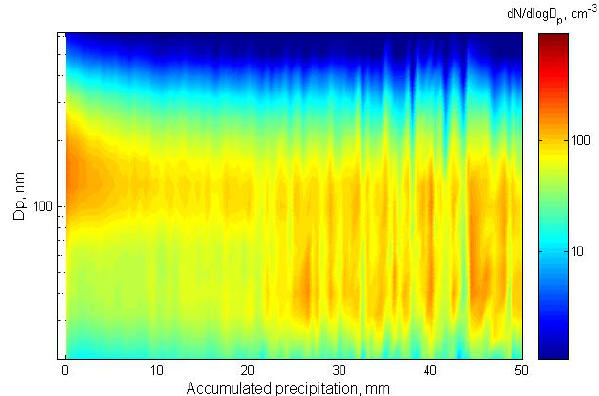
Fig. 16. Evolution of aerosol number size distribution as a function of accumulated precipitation (mm tot ) along 240 h trajectories. Data are shown binned over a step size of 0.5mm tot , and the correspond- ing size distributions over this ranges of precipitation is presented as median